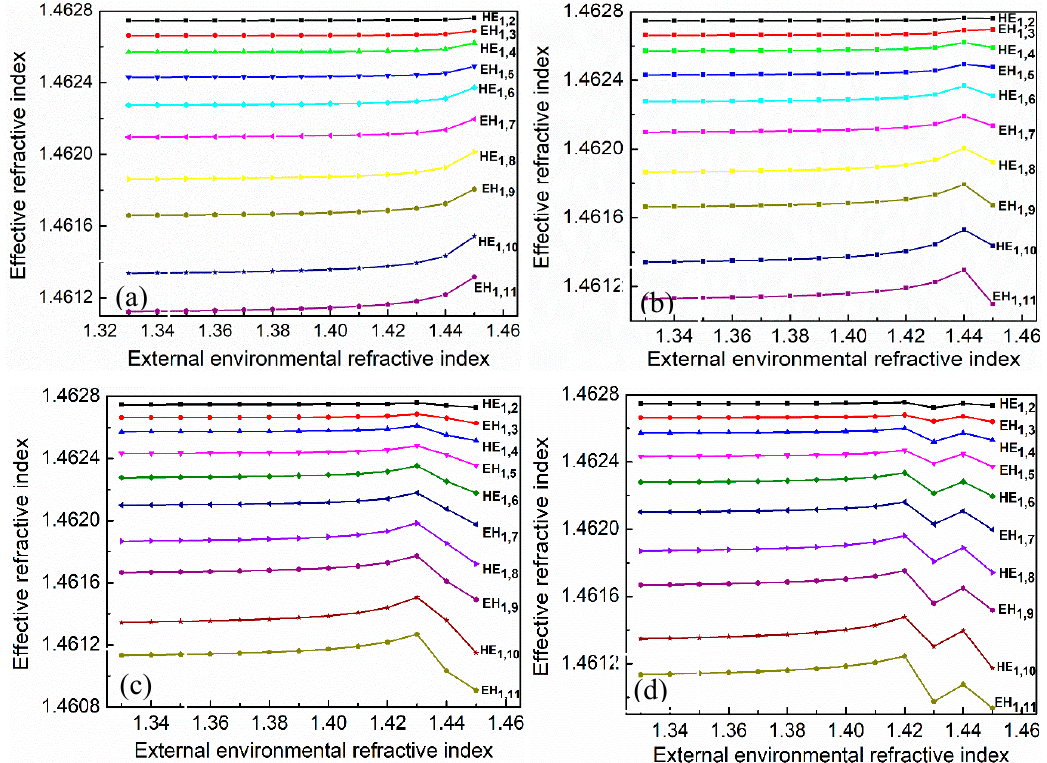
Figure 1. E ff ective refractive index of the first 10 cladding modes varies with the environmental refractive index, ( a ) R InGaZnO = 1.6, ( b ) R InGaZnO = 1.65, ( c ) R InGaZnO = 1.68, ( d ) R InGaZnO = 1.7.